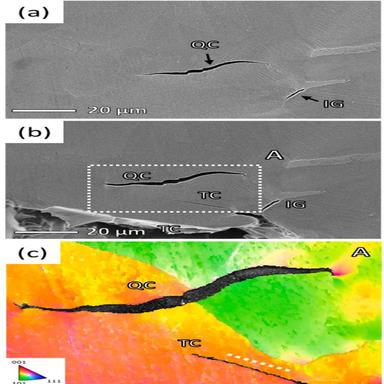
SEM images – (a, b) and EBSD IPF colour-coded map – (c) demonstrating the specific region of the side surface of the low-carbon steel S235JR specimen after the first- – (a) and second-step loadings – (b, c). The region represented in (c) is the magnified area outlined by "A" - labelled frame in (b). The white dotted line in (c) indicates the trace of the crystallographic planes. (For interpretation of the references to colour in this figure legend, the reader is referred to the Web version of this article.